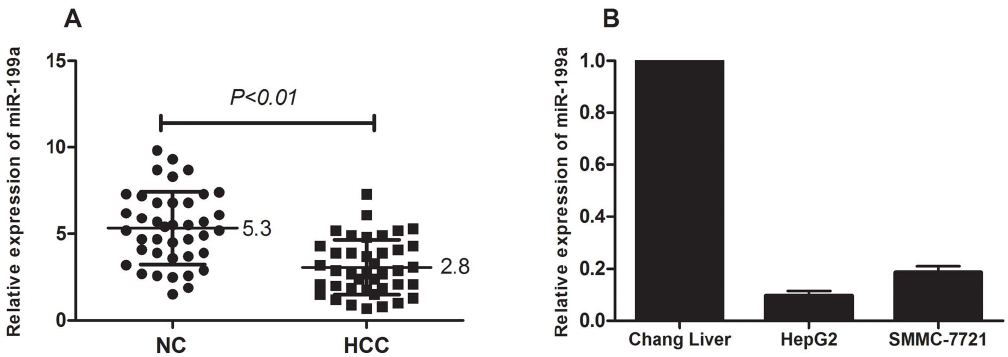
Figure 1. Down-regulation of miR-199a in HCC tissues and cell lines was detected by qRT-PCR. (A) The expression level of miR-199a was lower in 40 HCC tissues than in their pair-matched adjacent normal liver tissues ( P , 0.01). Each sample was analyzed in triplicate and normalized to the U6 snRNA. (B) The relative miR-199a expression in HCC cell lines was much lower compared to the normal Chang liver cell line. The relative expression of miR-199a was normalized to the endogenous control U6 snRNA. Each sample was analyzed in triplicate.